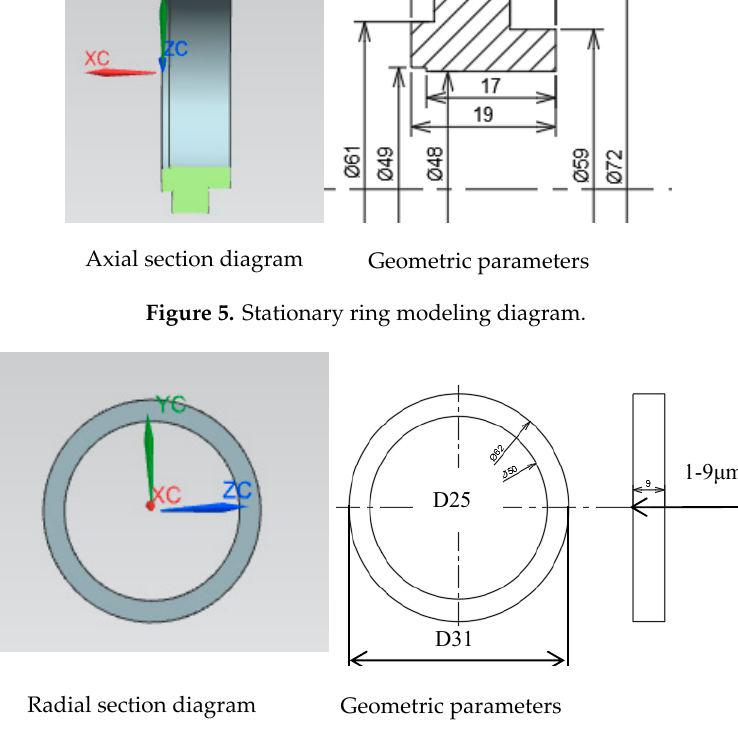
Figure 6. 3D diagrams of fluid film